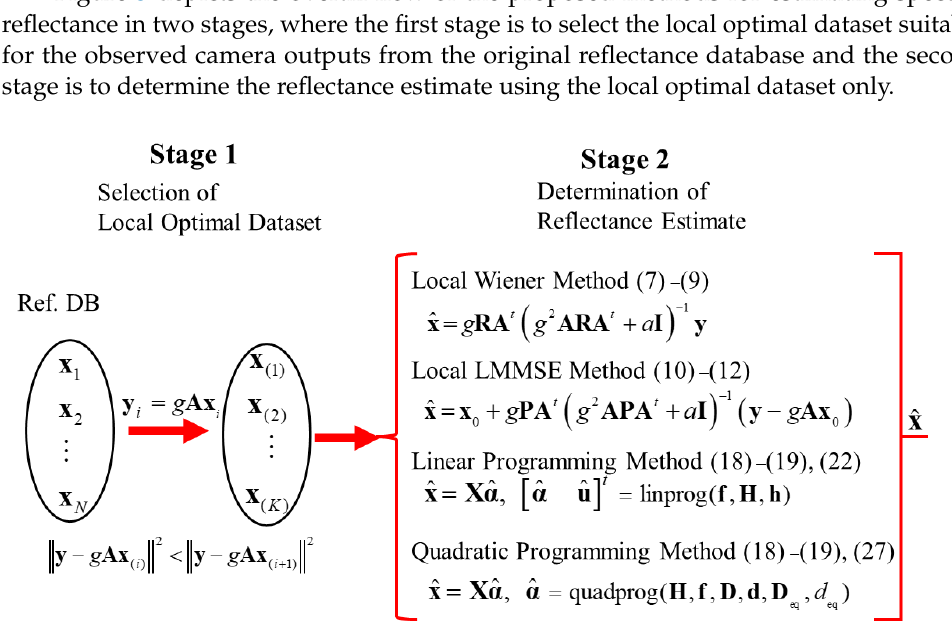
Figure 4. Relative RGB spectral sensitivity functions of three mobile phone cameras, where red, green, and blue curves correspond to Apple iPhone 6s, Apple iPhone 8, and Huawei P10 lite cam- eras, respectively.